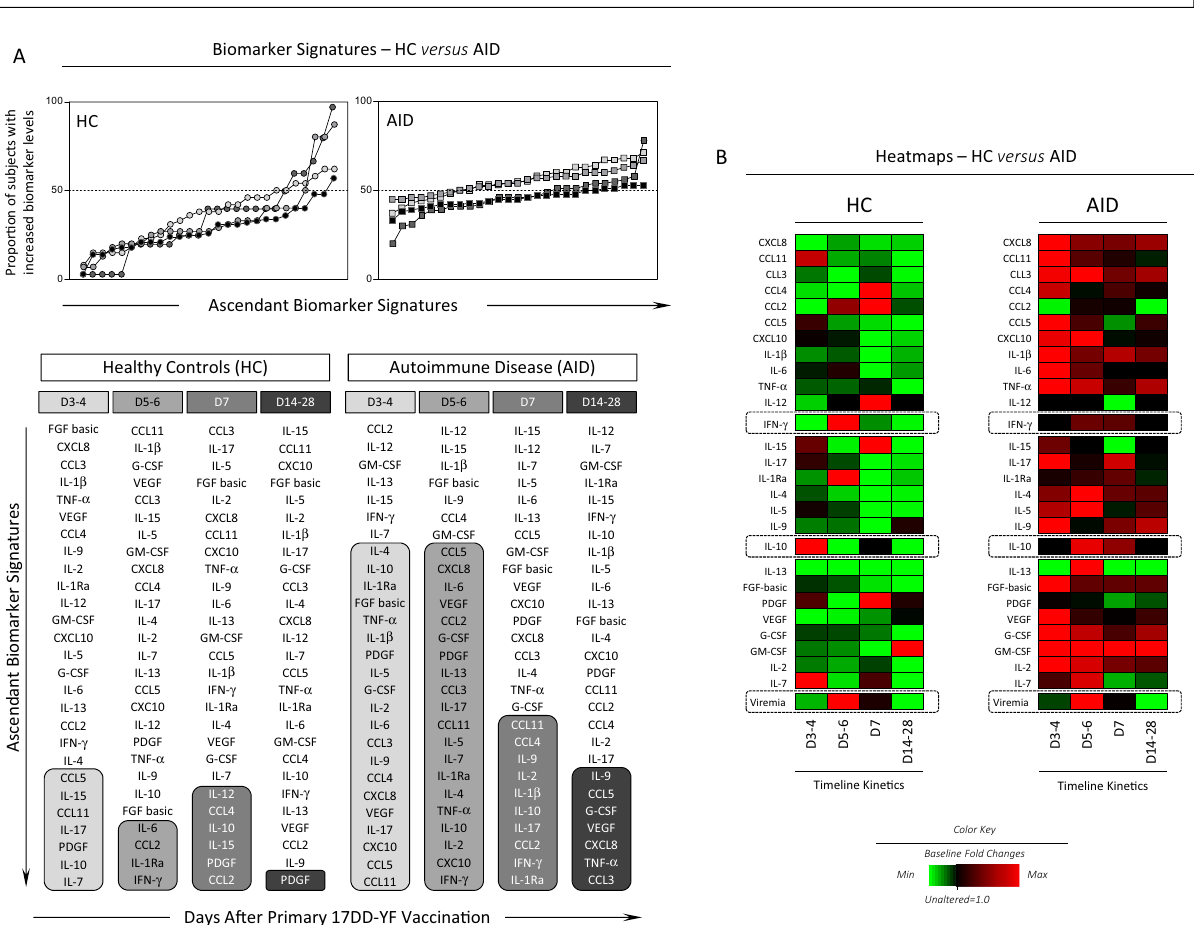
Biomarker Signatures in Pa(cid:9)ents with Autoimmune Disease A(cid:6)er Planned Primary 17DD-YF Vaccina(cid:9)on